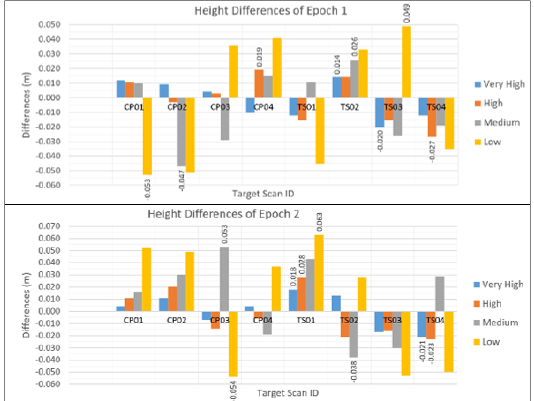
Figure 51. Height coordinates differences between point cloud data by picking point manually and Total Station data using intersection method (epoch 1 and